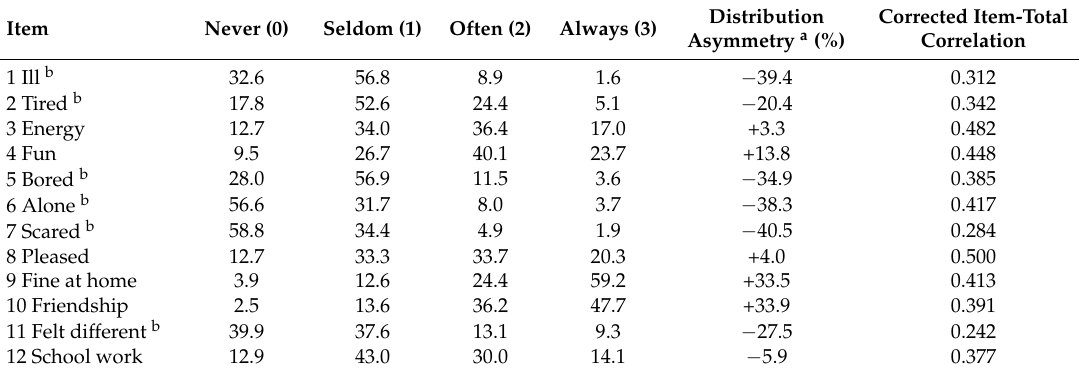
Table 3. Distribution (%) of scores in response to items of the HRQoL scale.